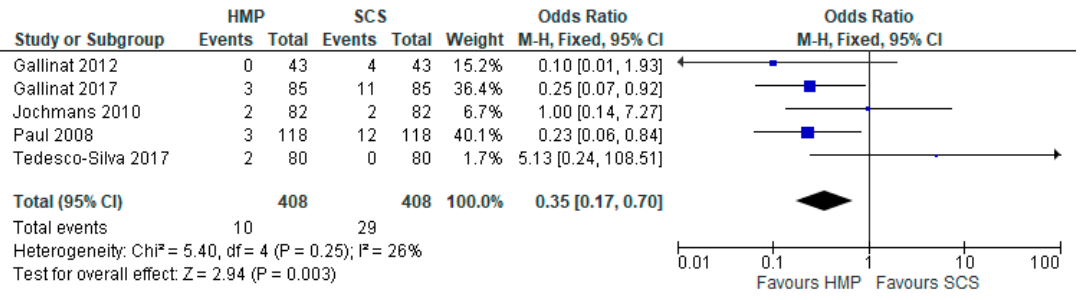
Figure 2. Primary nonfunction in kidneys preserved via HMP and SCS.